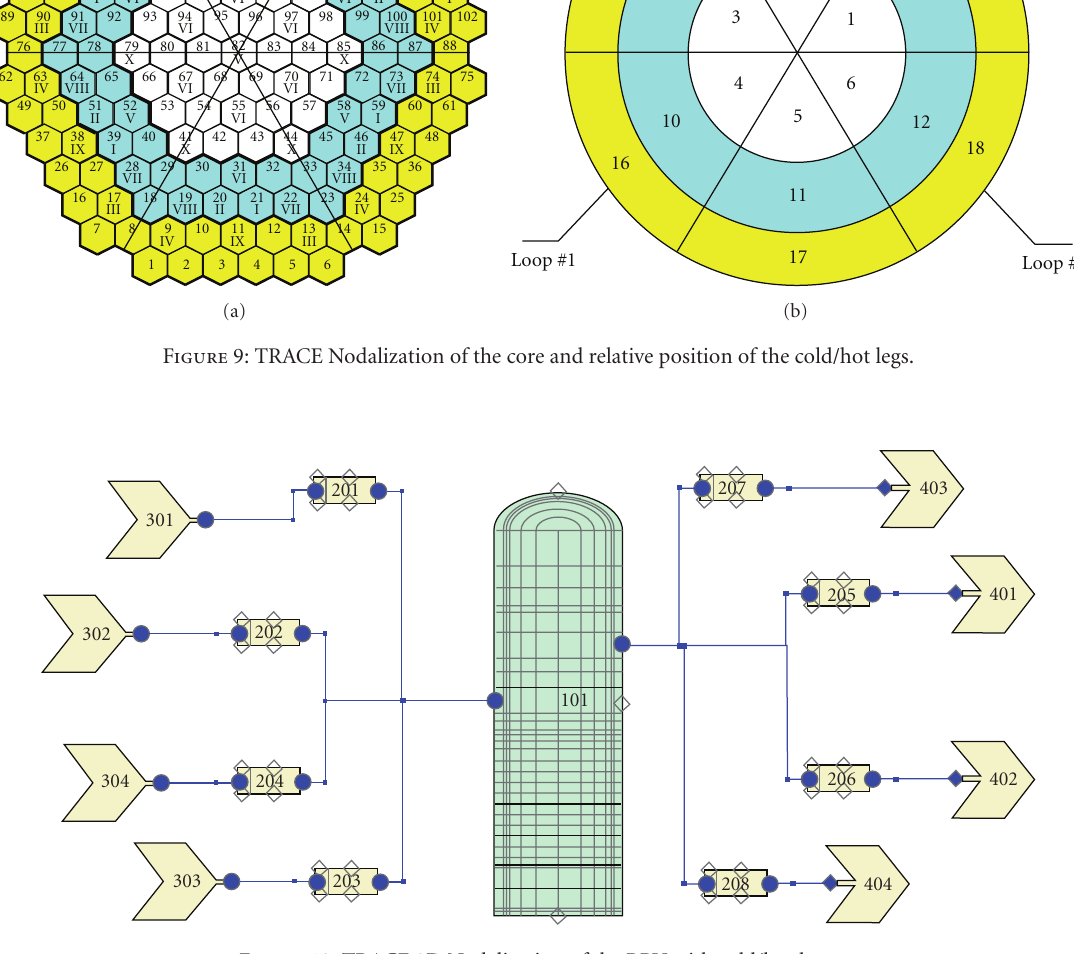
Figure 10: TRACE 3D Nodalization of the RPV with cold/hot